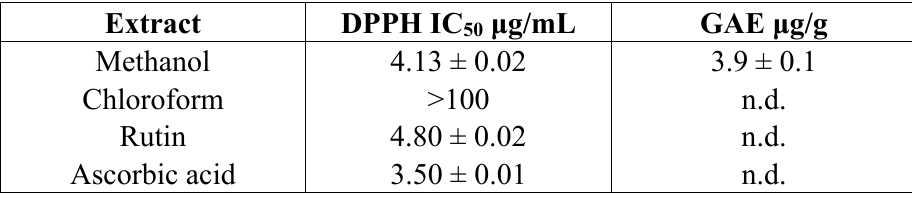
Table 1. Antioxidant activity of A. spectabilis bark extracts. Ascorbic acid and rutin were used as reference